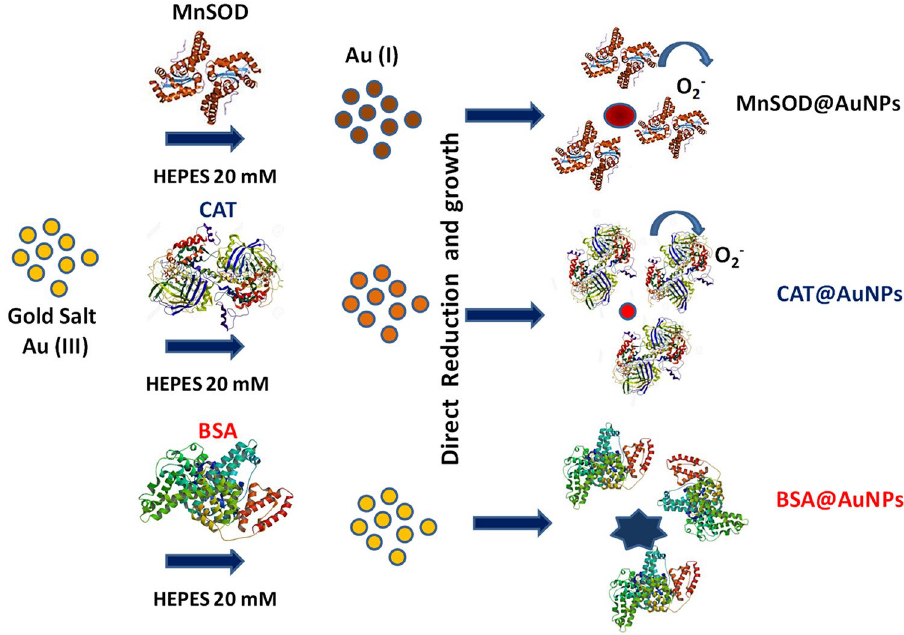
Figure 1. Scheme of the gold nanoparticle synthesis mediated by